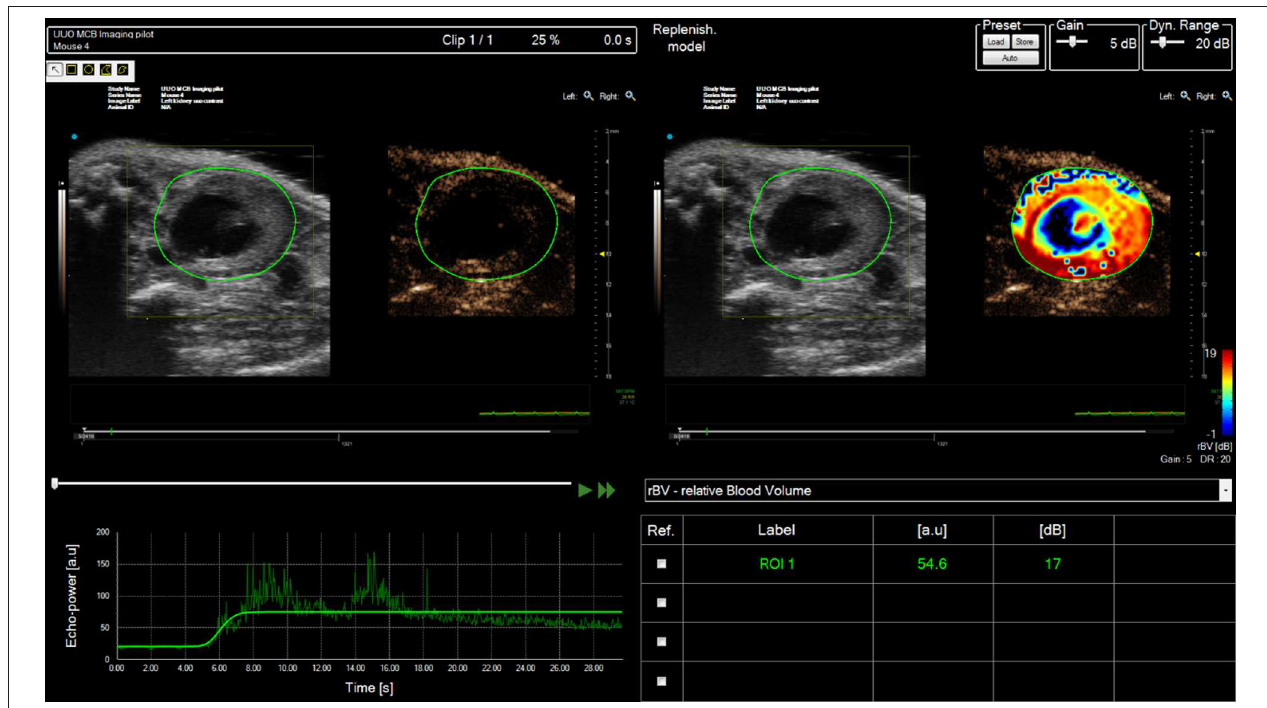
FIGURE 9 | Contrast analysis of data-set acquired from right mouse kidney post ischemia-reperfusion (IRI) injury after tail-vein bolus injection of SonoVue. Mouse scanned in prone position. Multiple regions of interest (ROIs) can be drawn onto the image and the enhancement can be tracked as a function of time (bottom LHS). The relative enhancement of each ROI relative to pre-contrast image can be calculated and color-encoded (Top RHS).